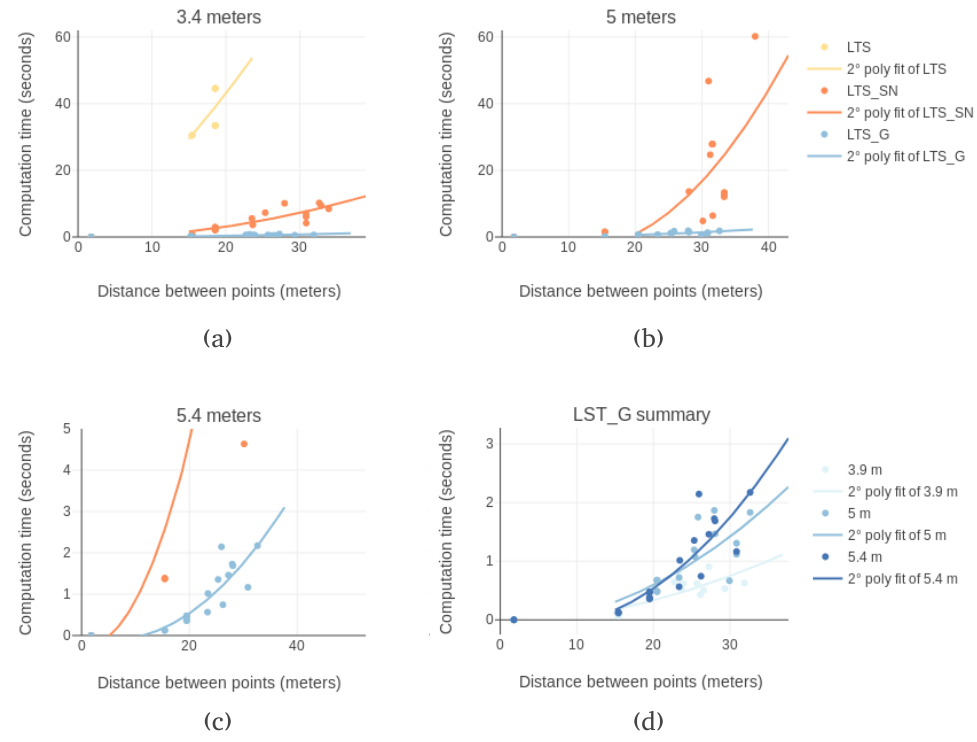
Figure 9. Computation times for different experimental snapshot flight corridors. The same paths are generated with increasing flight corridor widths. ( a ) Paths calculated with a 3.4 m flight corridor width. ( b ) Paths generated with a 5 m flight corridor width. ( c ) Paths computed with a 5.4 m flight corridor width. ( d ) The impact of the width of the flight corridor for LTS_G.